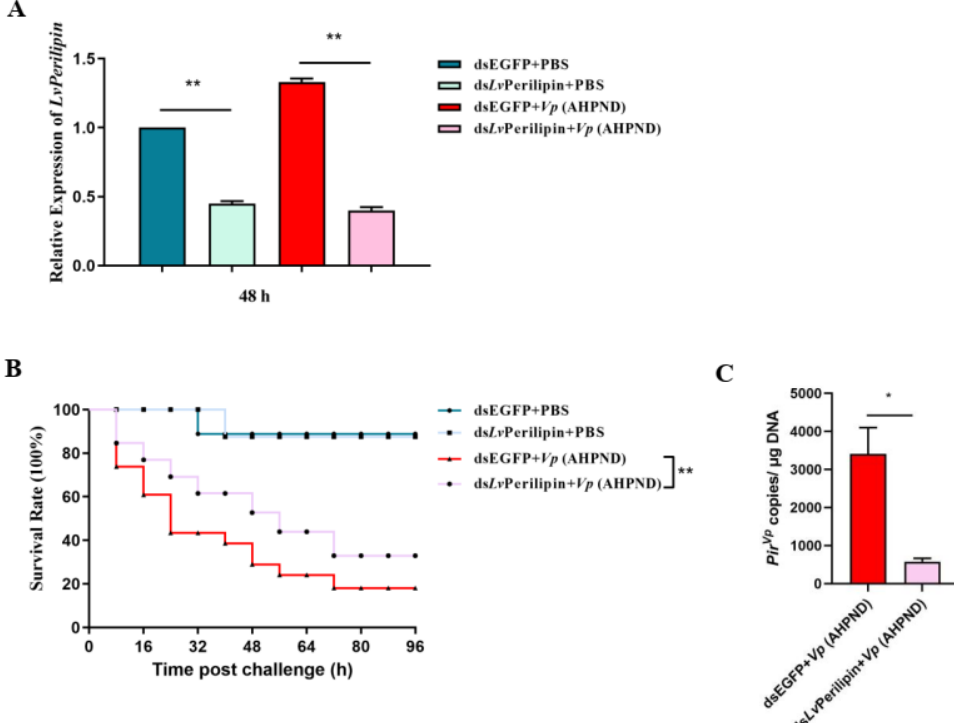
Figure 3. The effect of Lv Perilipin on shrimp survival rate and Vp (AHPND) proliferation. ( A ) The expression level of Lv Perilipin after RNAi. RNAi assay was performed as described in 4.4. The shrimp hemocytes were collected at 48 h post- Vp (AHPND) infection and subjected to determine the Lv Perilipin expression using qRT-PCR. ( B ) Silencing of Lv Perilipin contributed to shrimp survival during Vp (AHPND) infection. The survival rate of shrimps ( n = 40 per group) was determined after intramuscular injection with dsEGFP (negative control) or ds Lv Perilipin followed by Vp (AHPND) or PBS (negative control) injection, and the dead shrimp of each group was recorded at 8 h intervals. The shrimp survival rate was calculated using the product-limit method of Kaplan-Meier, and the significance was compared using the log-rank test. ( C ) Knockdown of Lv Perilipin suppressed Vp (AHPND) proliferation. DsEGFP (control group) and ds Lv Perilipin were injected into shrimps. After 12 h, the two groups were injected with 1 × 10 5 unit Vp (AHPND). The shrimp hemolymph ( n = 3 per group) was collected to extract genomic DNA, and 100 ng of each DNA was subjected to qRT-PCR analysis. Pir vp copies in 1 µ g of shrimp genomic DNA were then calculated. The data were statistically analyzed via the student’s t -test (* p < 0.05, ** p <